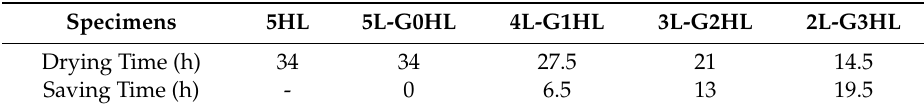
Table 4. The e ff ect of geopolymer coating substitution layers on preparation ceramic shell mould drying and